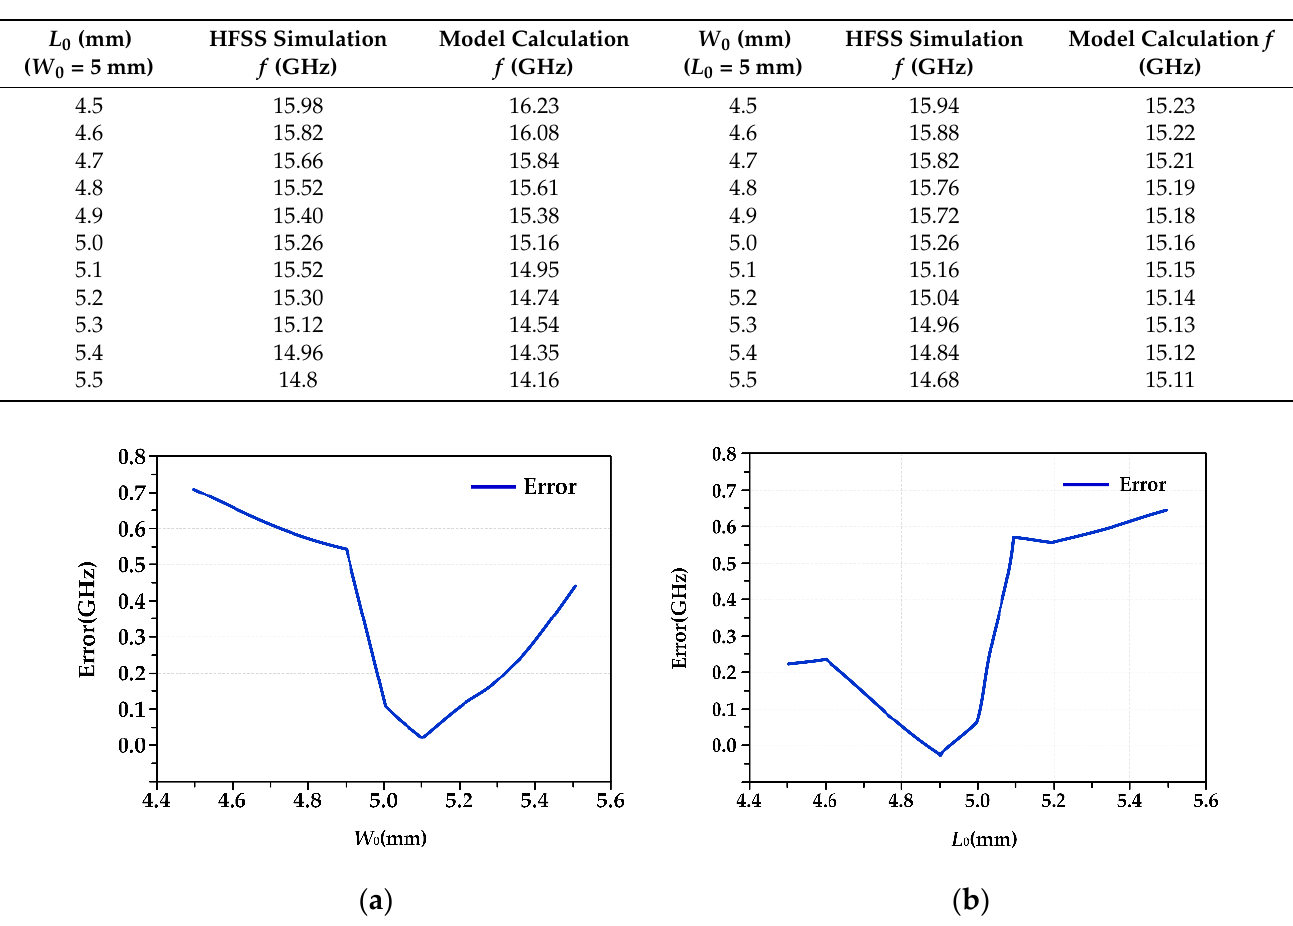
Figure 11. ( a ) Frequency calculation error (W0 parameter change); ( b ) frequency calculation error (L0 parameter change).